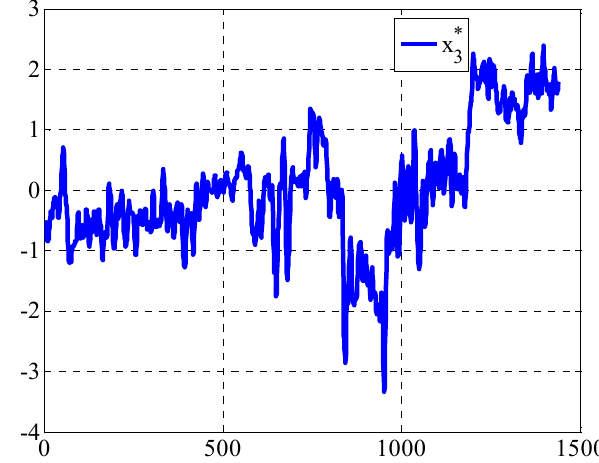
Figure 10. The standardized variable x ∗